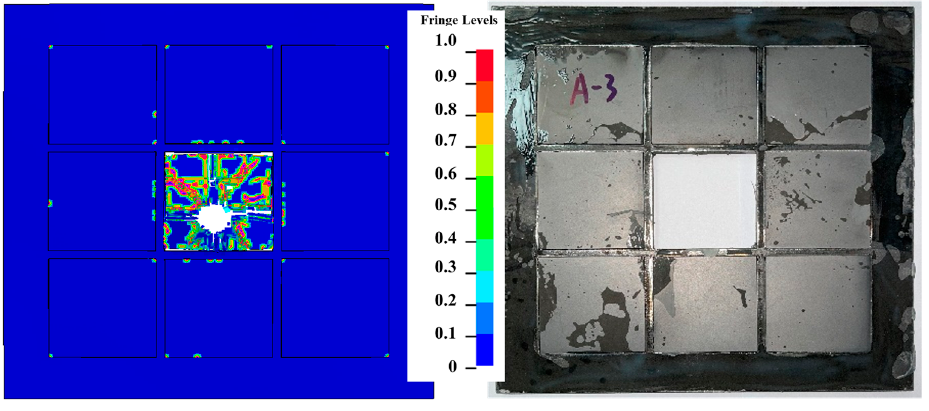
Figure 11. Damage contour of the ceramic tiles in T-X.